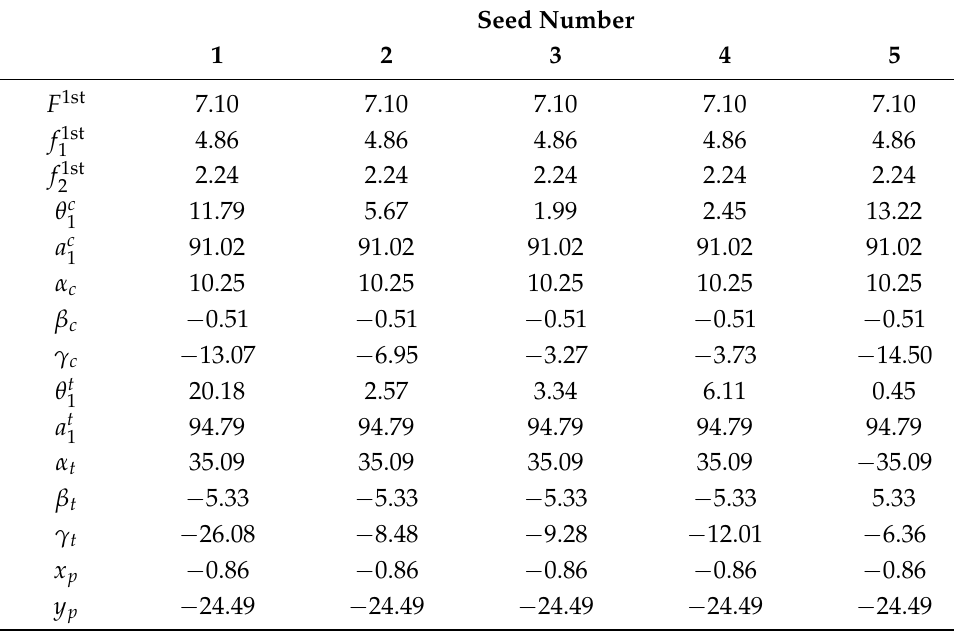
Table 8. Optimization results of the DH method after first-stage